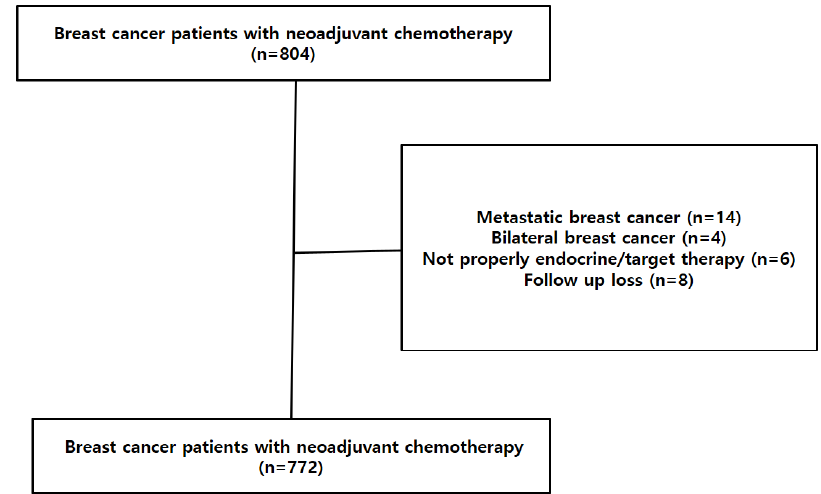
Figure 1. Consort diagram of patient selection with neoadjuvant Figure 1 . Consort diagram of patient selection with neoadjuvant chemotherapy.